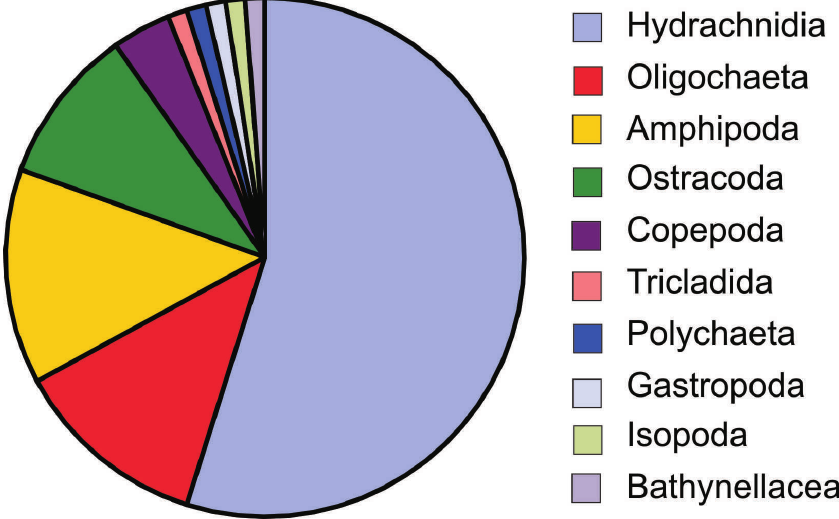
Figure 3. Percentage share of stygobiontic species from particular taxonomic